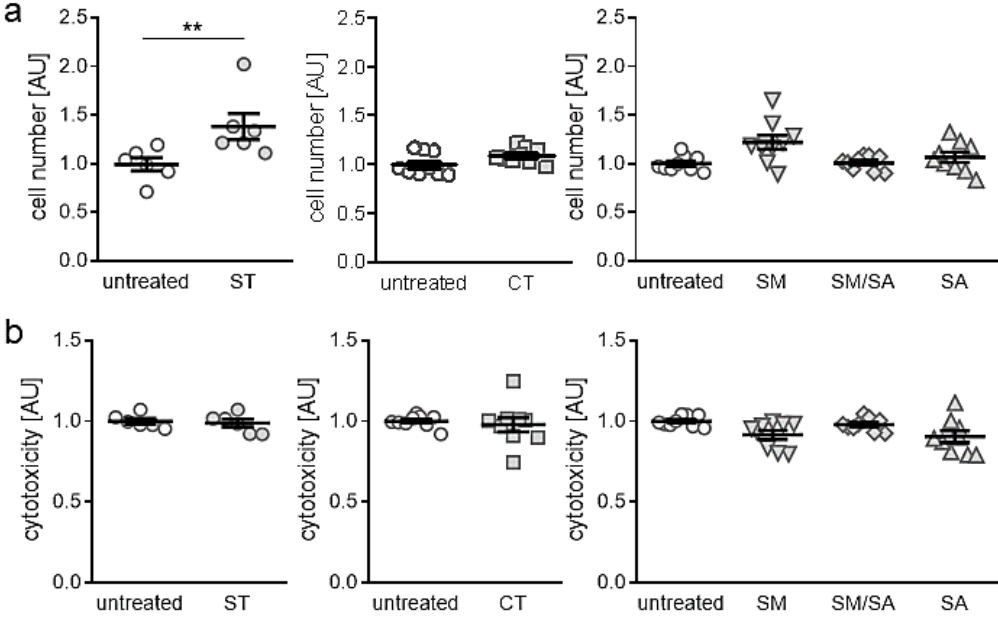
Figure 2. Assessment of cell numbers ( a ) and cytotoxicity ( b ) after application of different tensile strain protocols (explanation see manuscript text). AU: arbitrary units, error bars represent standard error of the mean. n > 6; Statistics: ST/CT: Mann-Whitney-U tests; SM, SM/SA, SA: Welch-corrected ANOVA with Games-Howell posthoc tests; ** p < 0.01.